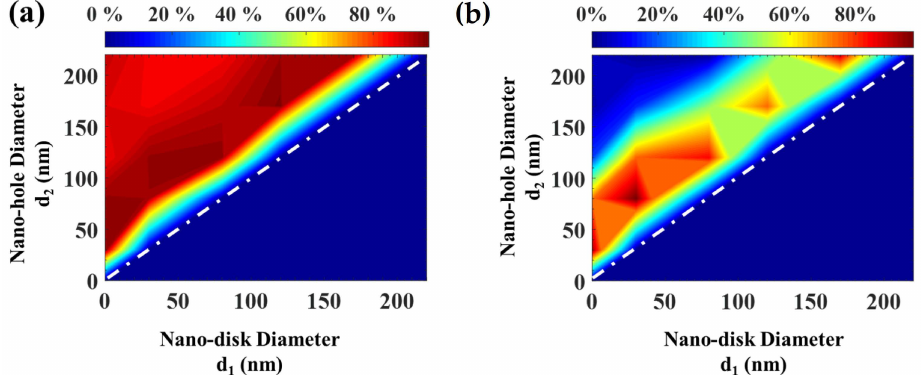
Figure 5. Modifications of the ( a ) RAB and ( b ) SAR of the designed disc-in-hole MPA due to changes in d 1 and d 2